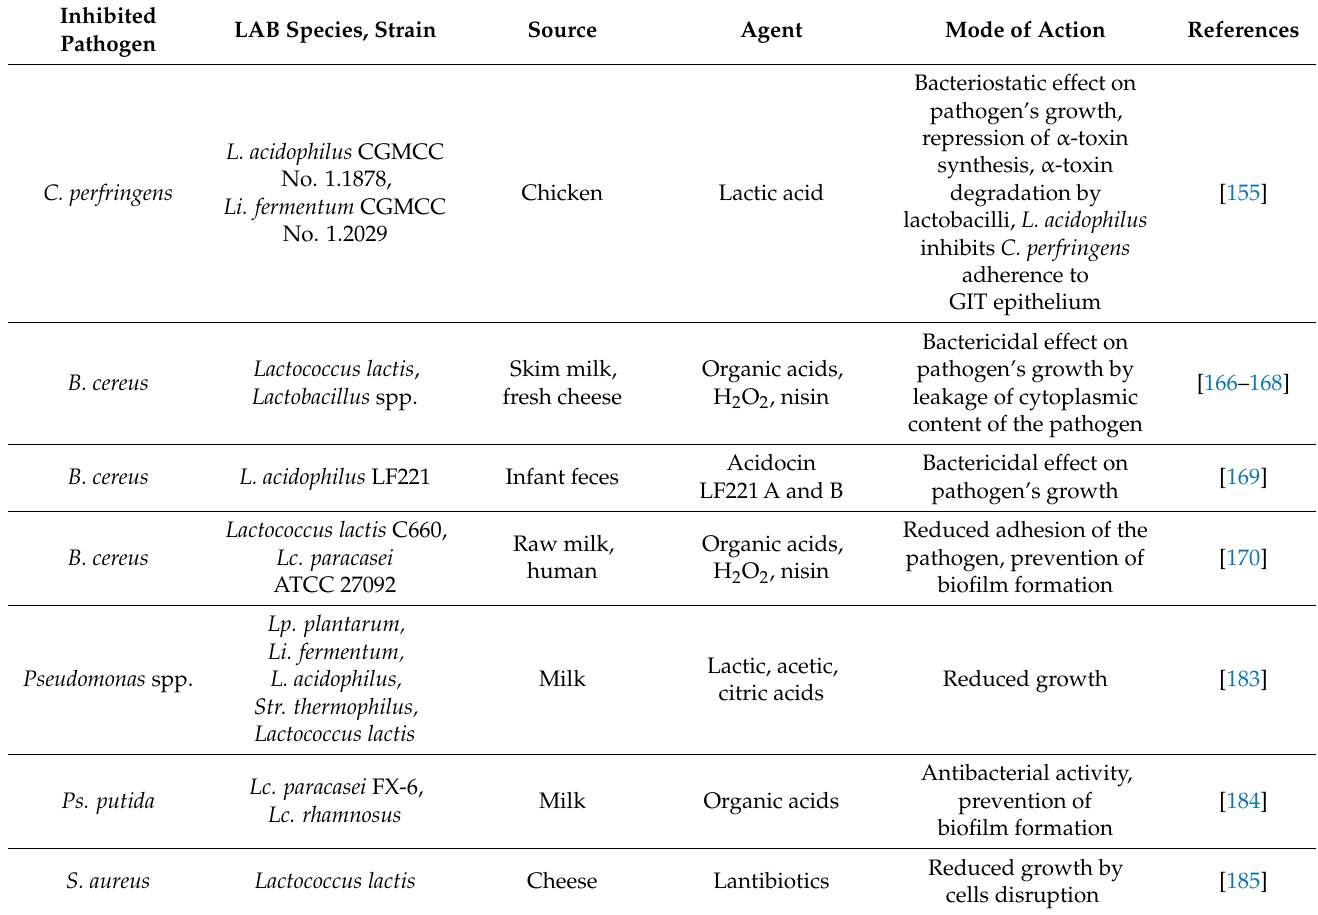
Table 4. Antibacterial activity of Lactic acid bacteria against other bacterial toxigenic